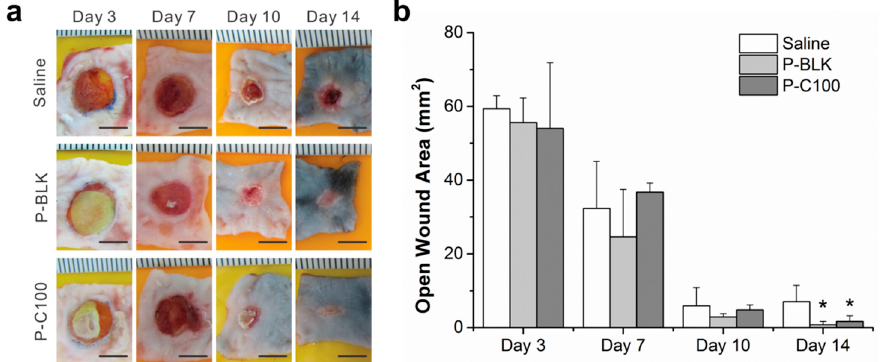
Figure 5. Macroscopic images ( a ) and wound closure measurement ( b ) of saline-, P-BLK-,